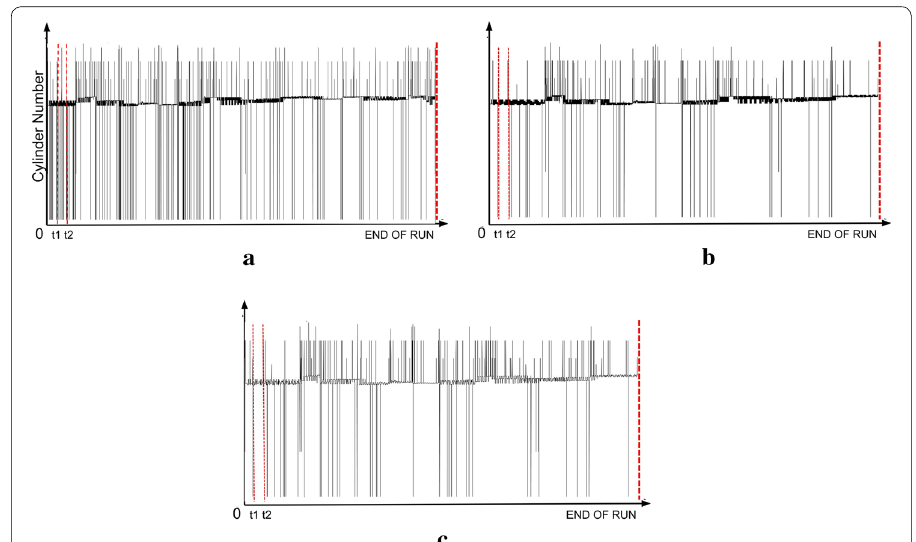
Fig. 13 Disk arm movements for WordStandardDeviation workload. a CFQ, b Noop, c BID-HDD